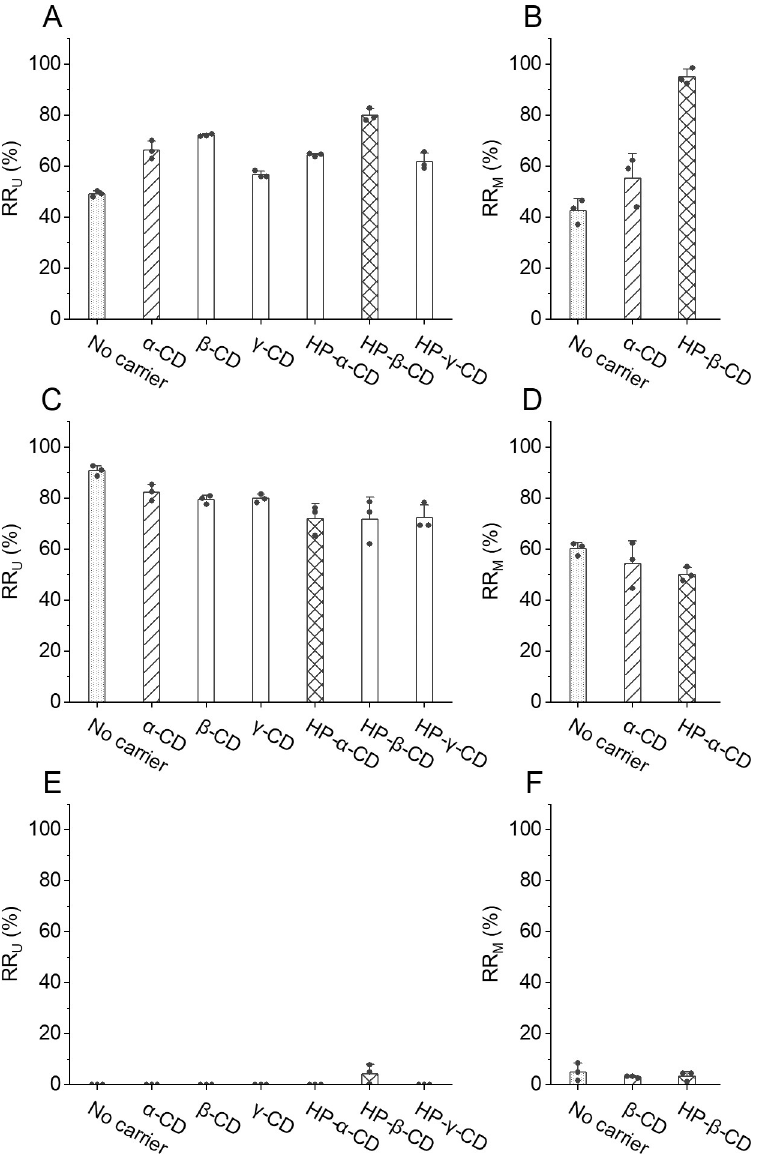
Fig 3. Carrier screening and method examination on three different drugs. The RR U of (A) risperidone, (C) temozolomide, and (E) albumin-bound paclitaxel were tested and screened when different cyclodextrins were used in centrifugal ultrafiltration. Cyclodextrins with high, middle, and low RR U in (A), (C), and (E) were selected to test their RR M in (B), (D), and (F) to examine this screening method. The selected groups were respectively filled with dots, slashes, and cross lines. All experimental data are presented in solid circles.